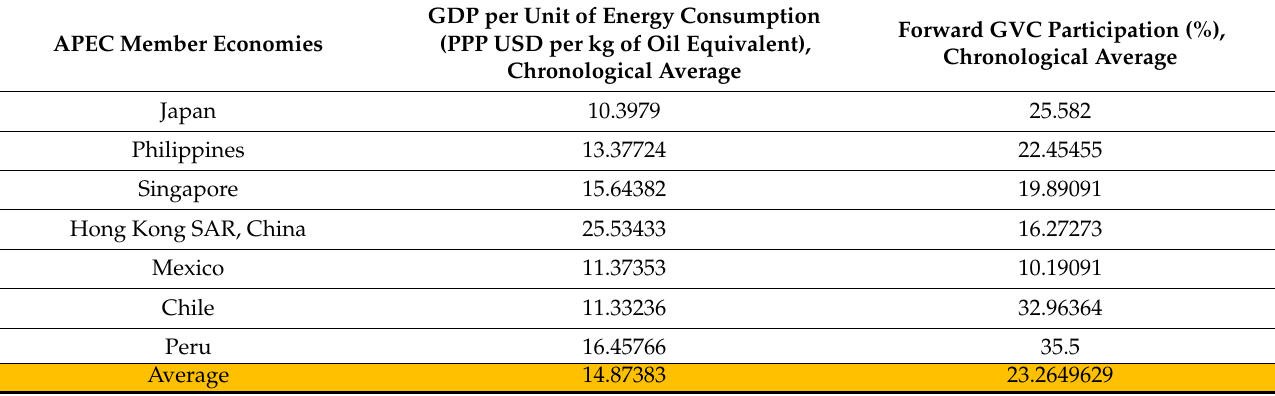
Table 6. APEC member economies with higher GDP per unit of energy consumption.